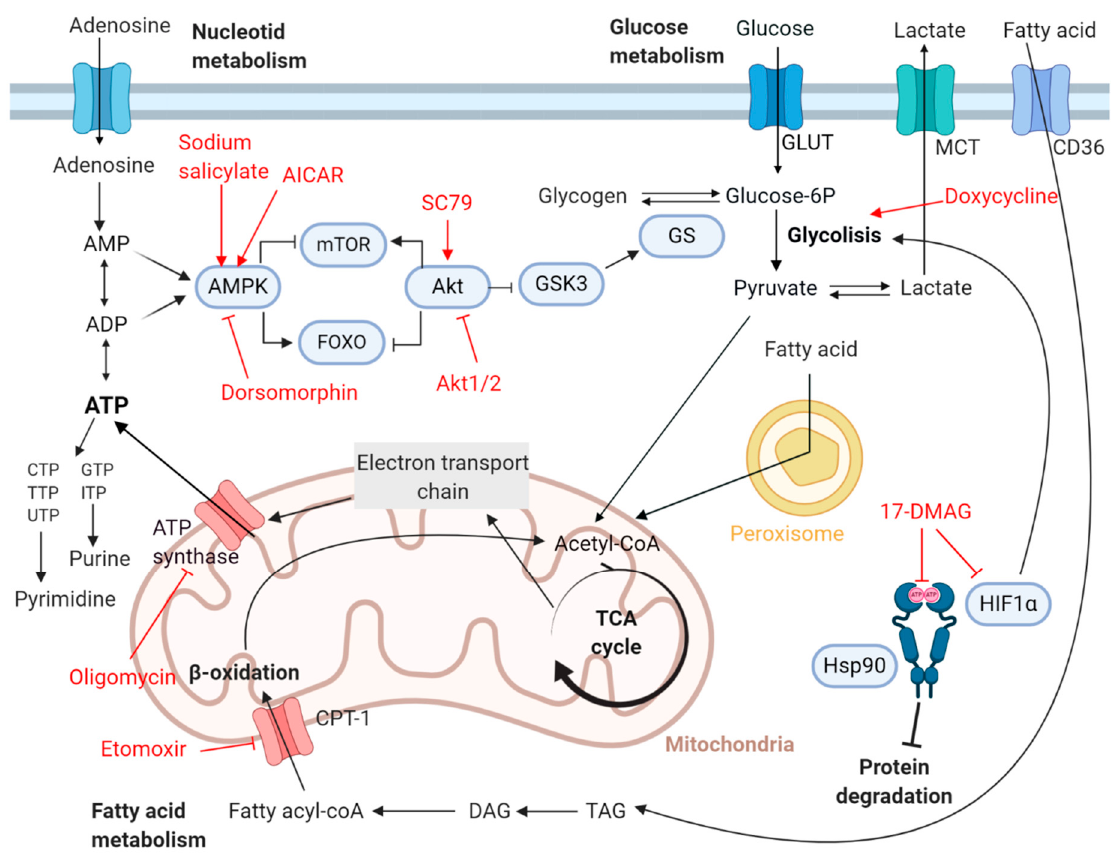
Figure 1. Host Cell Metabolic Routes Scheme. It shows known targets and effects on them of the compounds evaluated in this work. (Figure created with Biorender.com).